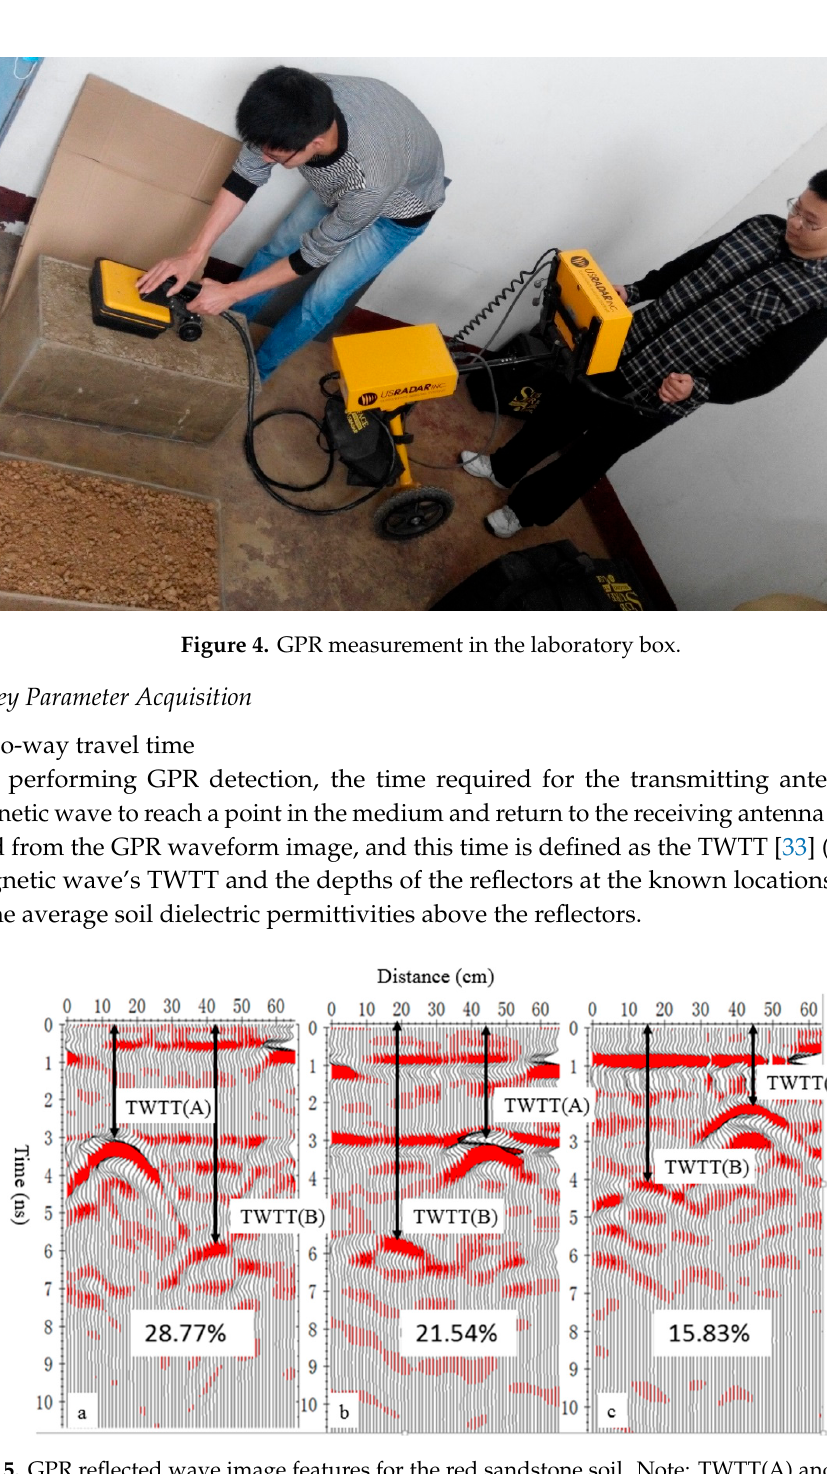
Figure 5. GPR reflected wave image features for the red sandstone soil. Note: TWTT(A) and TWTT(B) represent the two-way travel times of reflectors A and B, respectively; the SWCs of ( a – c ) are